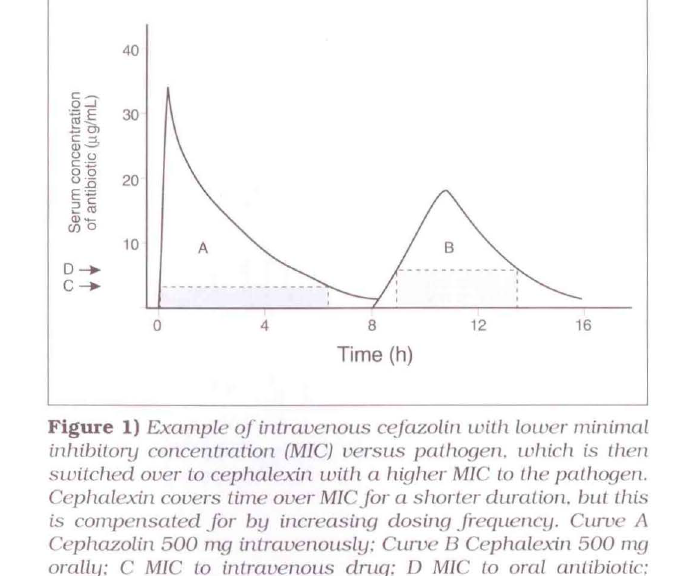
Figure 1) Example of intravenous cefazolin wilh lowc>r minimal inhibilo,·y concenlralion (MIC) versus pathogen. which is lhc>11 switched over lo cephalexin with a higher MIC lo the palhogen. Cephalexi11 covers lime over MIC for c1 s/10rle1· duration. bul lhis is compensated for by increasing dosing frequency. Curve I\ Cephazolin 500 mg intravenously: Curve B Cephalexin 500 mg orally: C MIC lo intravenous drug: D MIC lo oral a11libiolic: Shaded area under cw1Je A: Time over MIC intravenous drug: Shaded area under curve B: Time over MIC oral